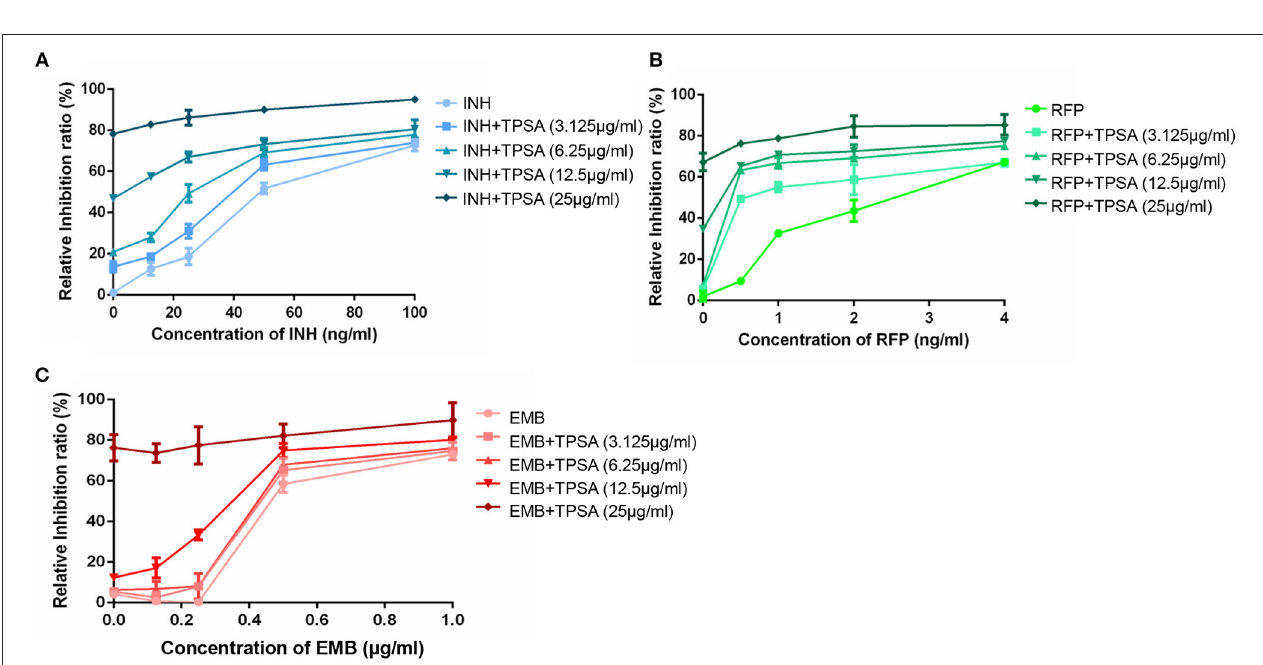
FIGURE 5 | The relative inhibition ratio of the synergistic effect on H37Ra between TPSA and three first-line drugs isoniazid (A) , rifampicin (B) , and ethambutol (C) . Data are representative of one experiment with three independent biological replicates (mean and SD).